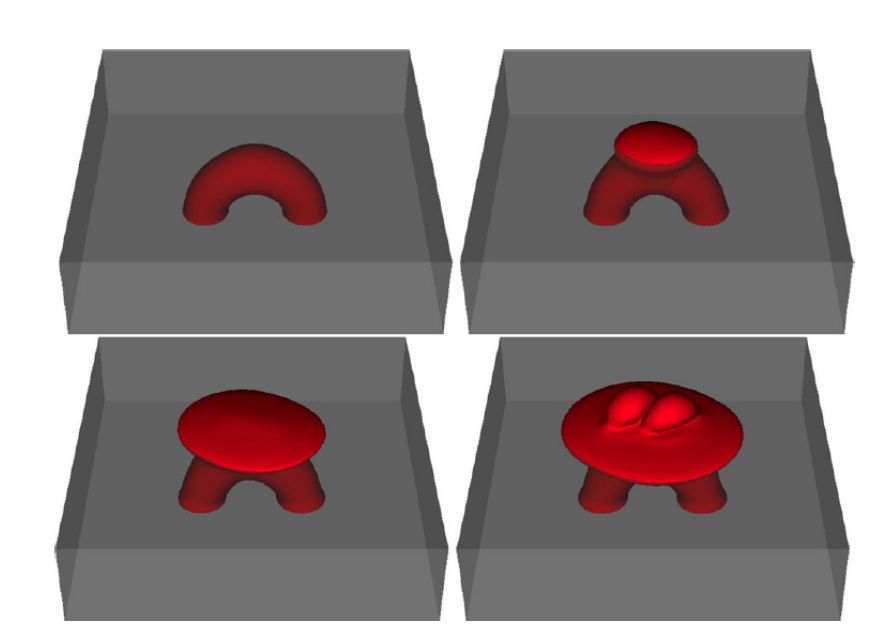
Figure 22: Isosurface of the magnitude of the magnetic field in the 3D simulation of the emergence of twisted and toloidal flux tube. The times are 𝑡 = 0 (top left), 40 (top right), 60 (bottom left), and 80 (bottom right). Image reproduced with permission from Hood et al. (2012), copyright by Springer.